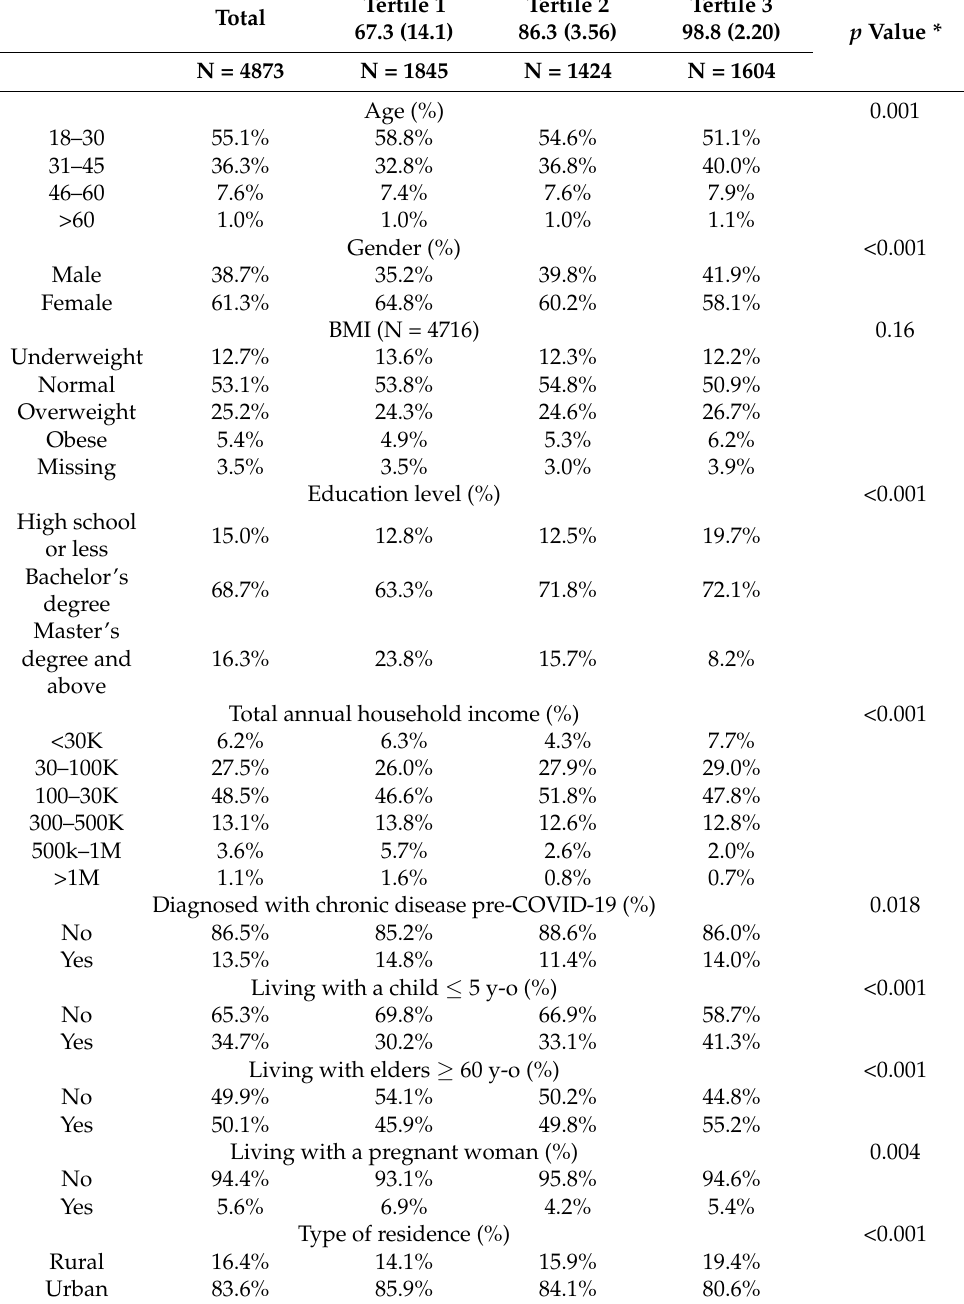
Table 2. Study participant characteristics by rate of confidence in the protectiveness of the COVID-19